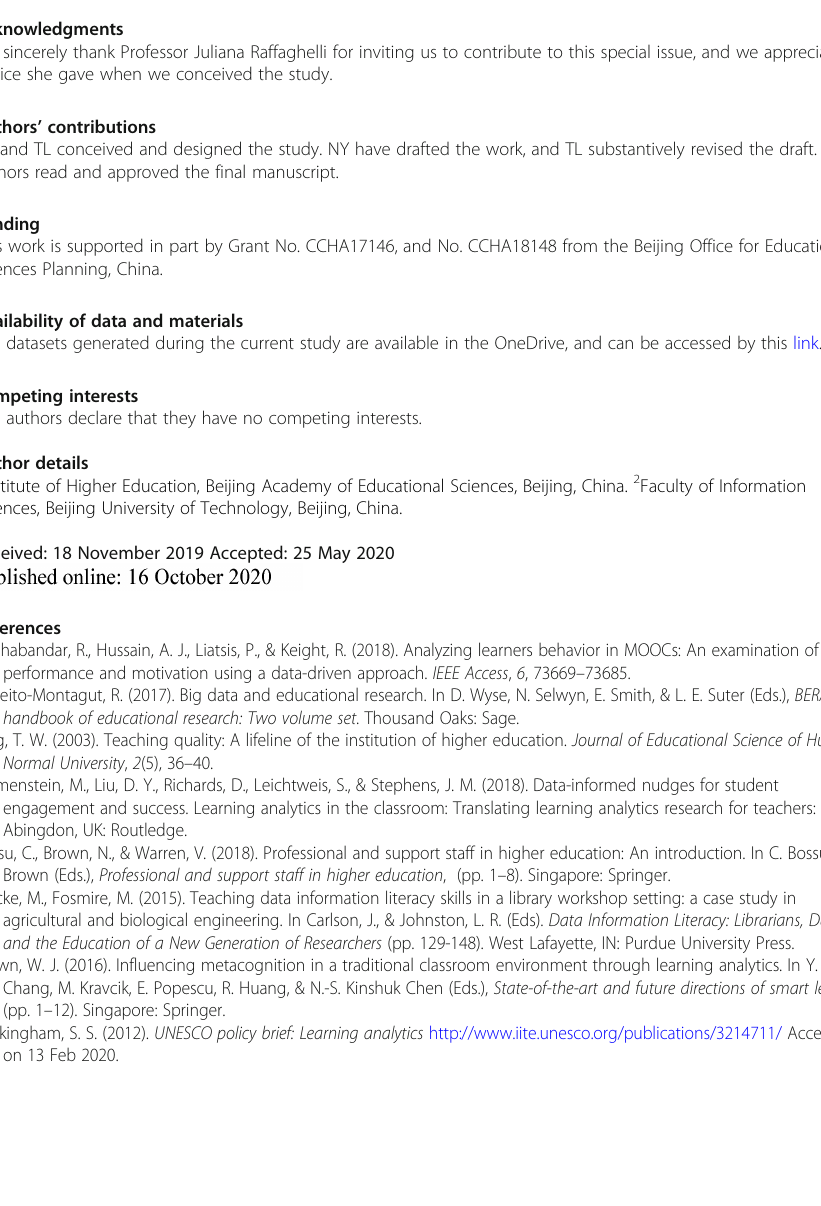
Students Faculty Agree (%) Members (%) (%) Staff